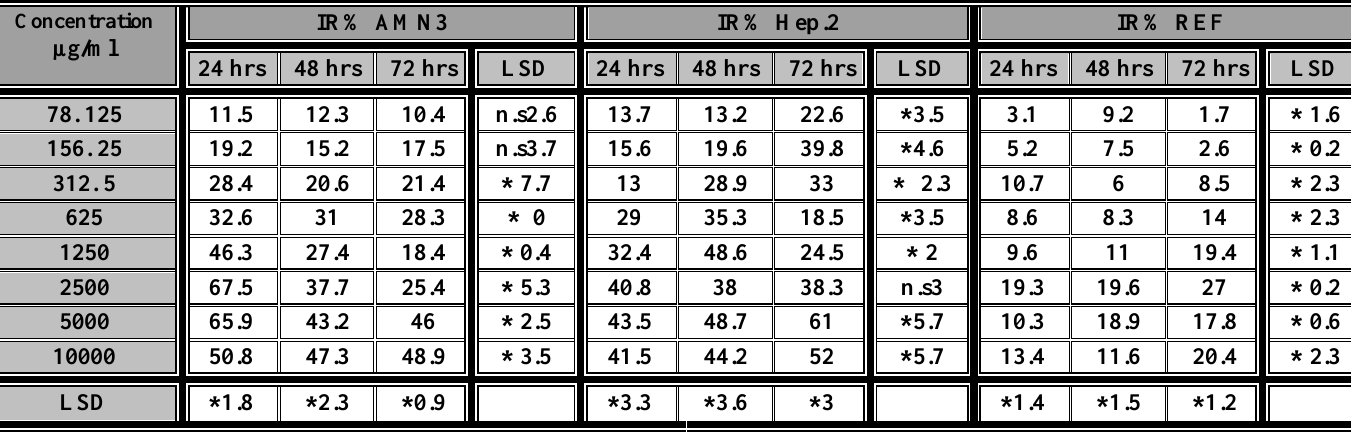
(*) Significant difference between means (comparison between columns and comparison with rows at levels (P<0.05).(n.s) Non-significant difference between means. Table (2): Mean values of inhibition rate (IR%) of (AMN3, Hep.2 and REF )cell lines after treatment with different concentrations of cold aqueous extract of Sonchus oleraceus for (24, 48 and 72) hours.